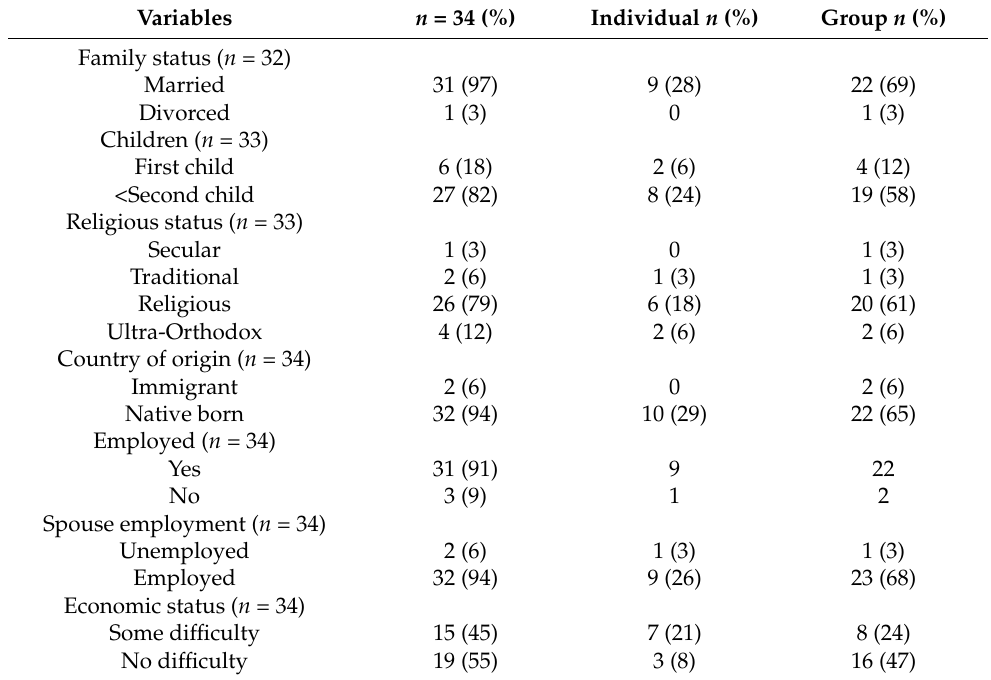
Table 1. Sociodemographic characteristics of the whole sample and by intervention